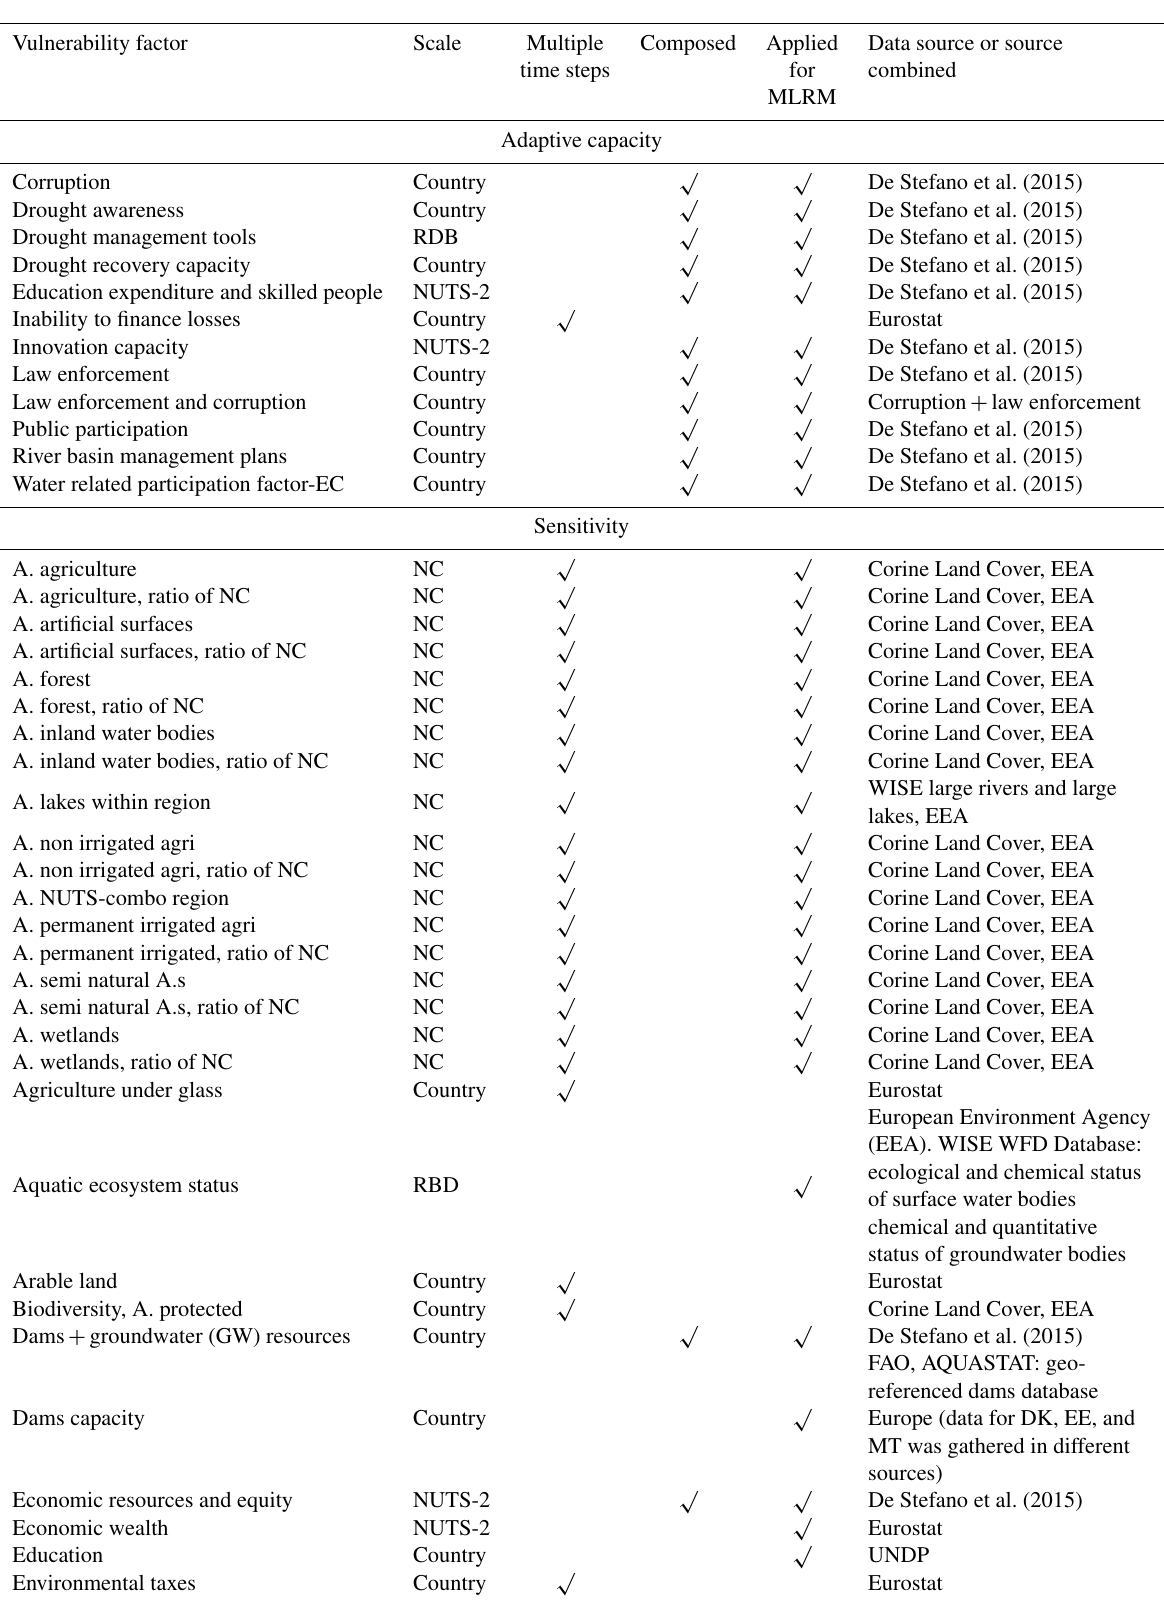
Table 2. Factors used to assess